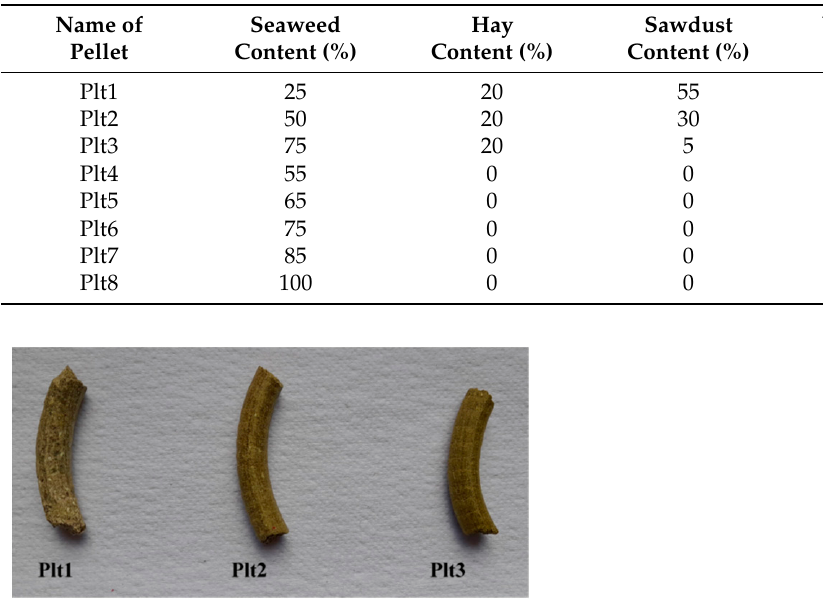
Table 1. The composition of the eight pellet types.